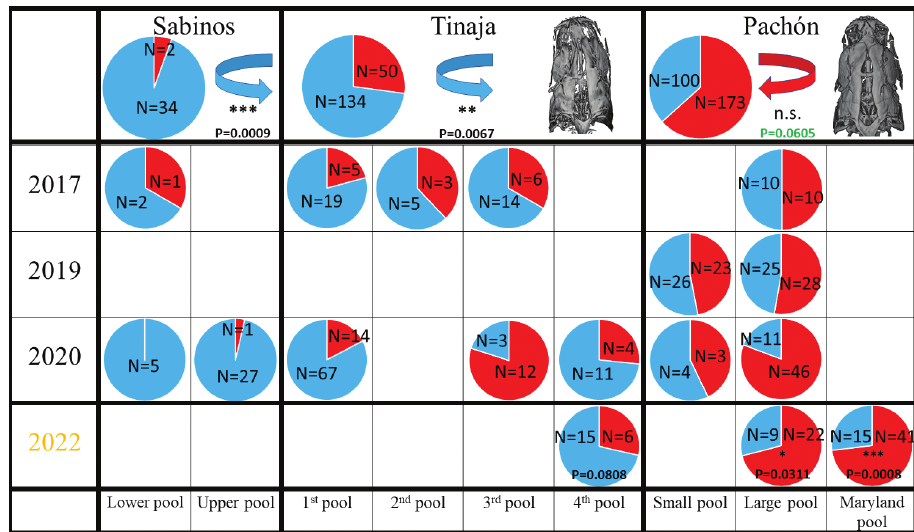
Figure 3. Preponderance in circling a vibrating stimuli using the left side or right side in different cave pools and times. As a population and throughout time, Sabinos and Tinaja cavefish used significantly more their left side. When all years and pools are included, Pachón showed a border line P = 0.0605 (in green) for not significantly differing from a 1:1 ratio. N’s in upper row are for all four years. But when the enhanced data collecting method was used in 2022, fish from two Pachón pools significantly used their right side more. Videos from 2017–2020 are from Espinasa et al. (2021). For the recordings of 2022, methodology was improved such that it guaranteed that data was from independent fish within the popu- lation, allowing for statistical analyses for that single pool and